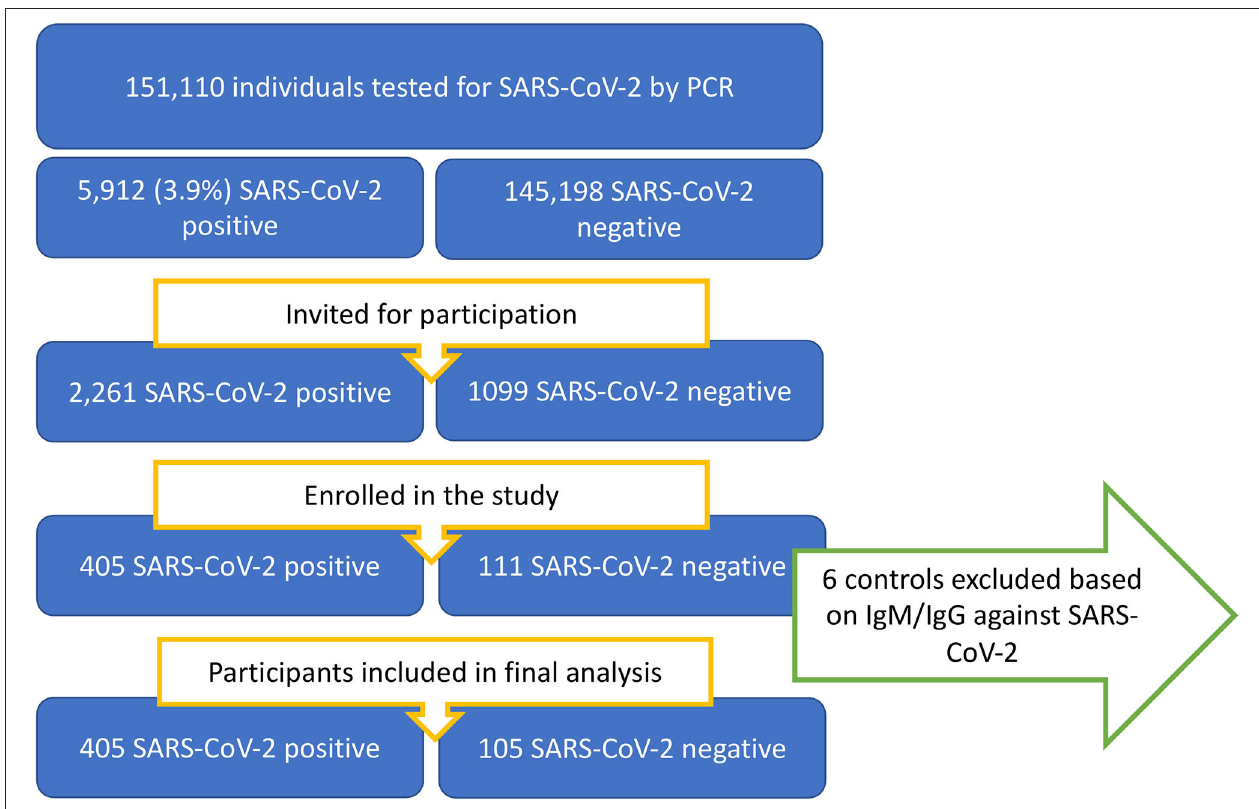
FIGURE 1 | Flowchart of patient availability, identification, and recruitment process.